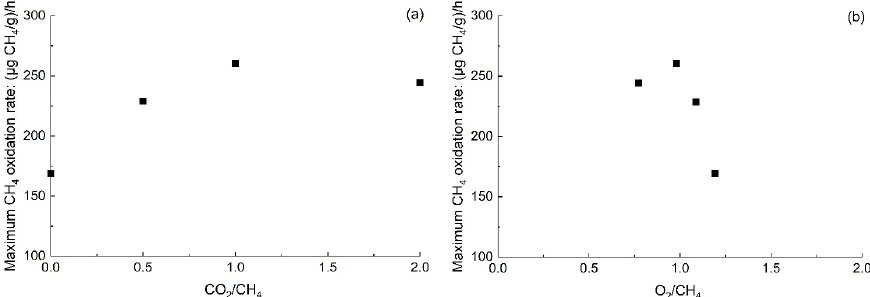
Figure 8. Relationship between maximum methane oxidation rate and ( a ) CO 2 /CH 4 and ( b ) O 2 /CH 4 in the serum bottle.